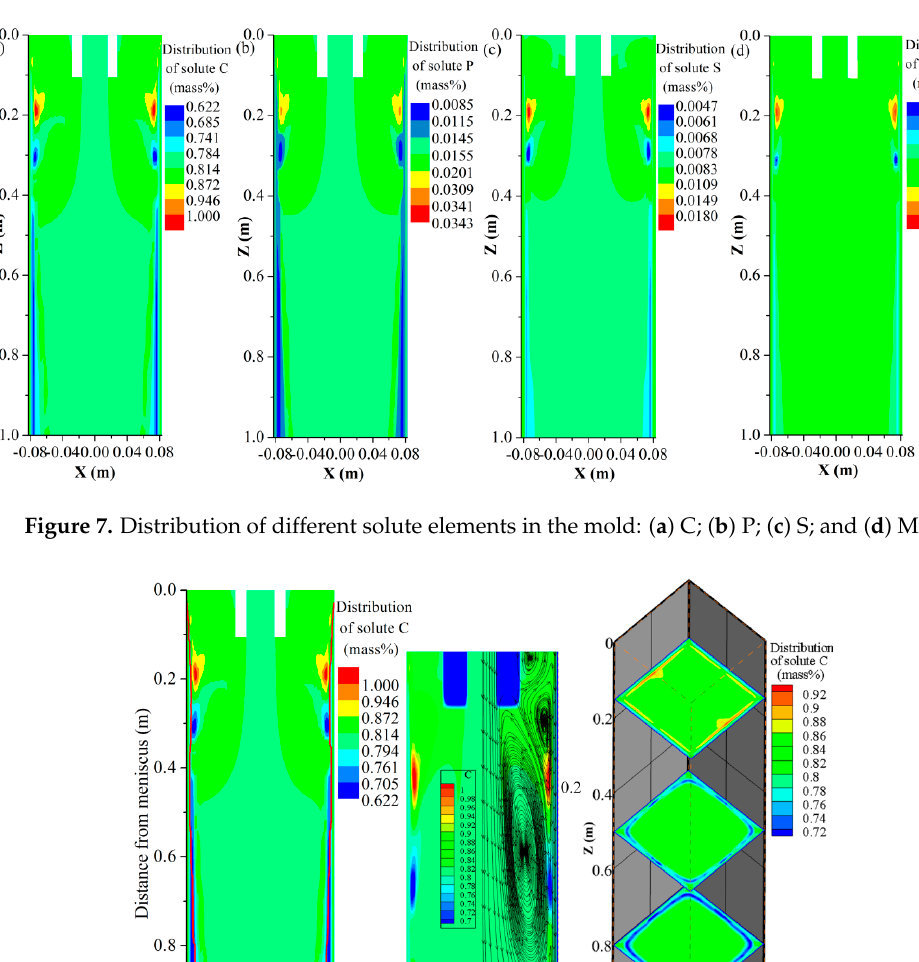
Figure 9. Predicted profiles for the concentration of solute C and liquid fraction: ( a ) Z = 0.18 and 0.30 m; and ( b ) Z = 0.5 and 1.0 m. The segregation degree is defined to directly describe the solute distribution: , = i